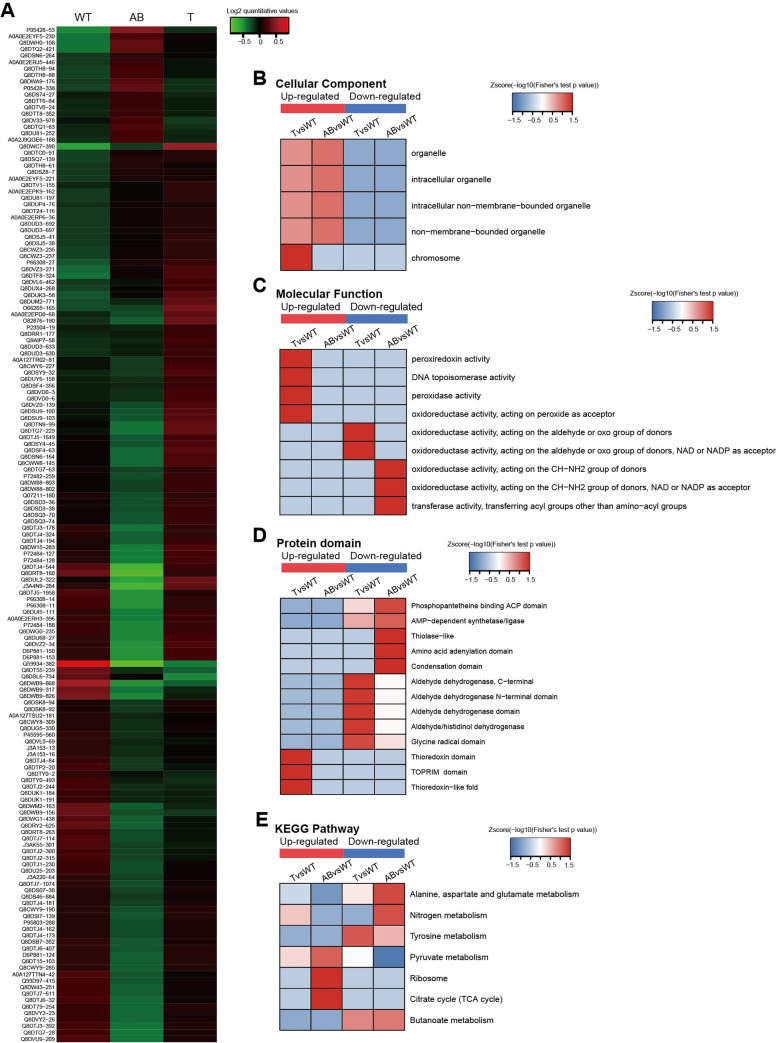
S-glutathionylation of proteins is differentially modified after deletion of gshAB and gsT.(A) A heatmap was used to visualize the significant differentially modified sites. log2(quantitative value) > 0 means that the modification level was upregulated and log2(quantitative value) < 0 indicates that the level was downregulated. (B) GO enrichment-based cluster analysis of the cellular components of differentially modified proteins. (C) GO enrichment-based luster analysis of the molecular functions of differentially modified proteins. (D) Domain enrichment-based cluster analysis of differentially modified proteins. (E) KEGG enrichment-based cluster analysis of the pathways of differentially modified proteins. The Z-score represents the–log10(Fisher's test P-value in enrichment analysis).